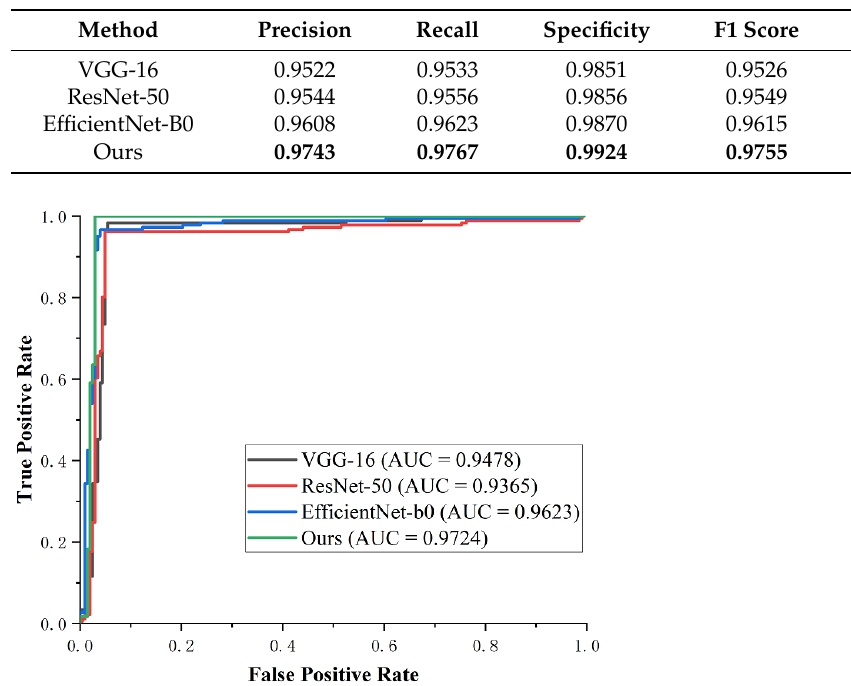
Table 7. Classification performance of the proposed method on dataset BT-4C.